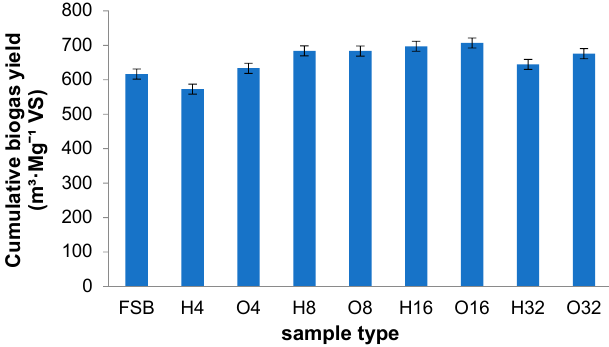
Energies 2020 , 13 , x FOR PEER REVIEW Figure 3. Cumulative biogas yield obtained from 1 mg of total solids (TS). Figure 3. Cumulative biogas yield obtained from 1 mg of total solids (TS).